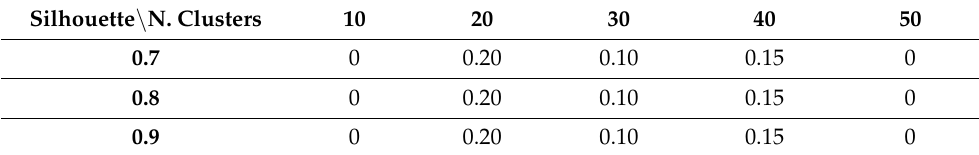
Table 34. Clustering performance in terms of silhouettes using normalized data. Silhouette \ N. Clusters